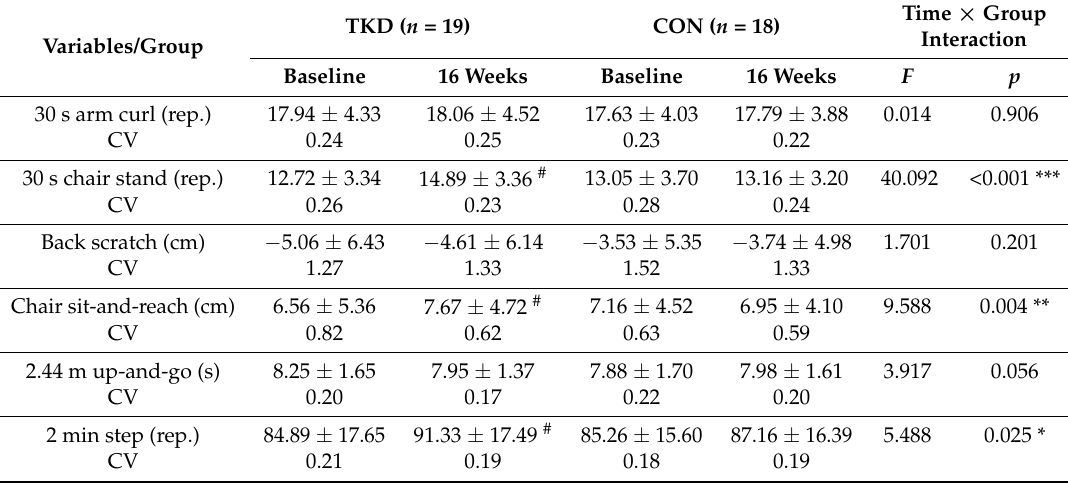
Table 3. Senior Fitness Test (SFT) parameters in the TKD and CON groups before and after the 16-week intervention.